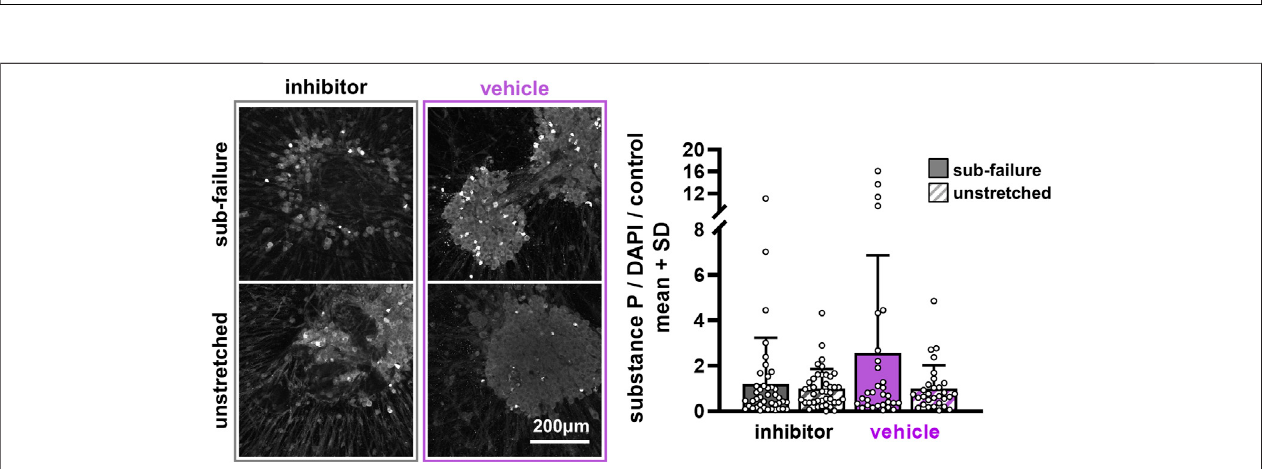
FIGURE6| SubstancePislargelyunchangedat24 hafterpre-treatmentwithilomastatinhibitororvehiclesolution.ExemplaryimagesofsubstancePlabeling24 h after stretch demonstrate similar expression levels between sub-failure and unstretched gels in inhibitor-treated DRG soma that are re fl ected in the summary data ( p = 0.114; MANOVA, n = 7/stretch condition). Vehicle-treated soma, however, show more abundant labeling in the gels undergoing sub-failure stretch, with stretch increasing substance P levels to 2.56 ± 4.29-fold over unstretched gels ( p = 0.165; MANOVA, n = 5/stretch condition). Superimposed data points represent quanti fi cation in each confocal image acquired ( n = 6/gel). The scale bar applies to all images.